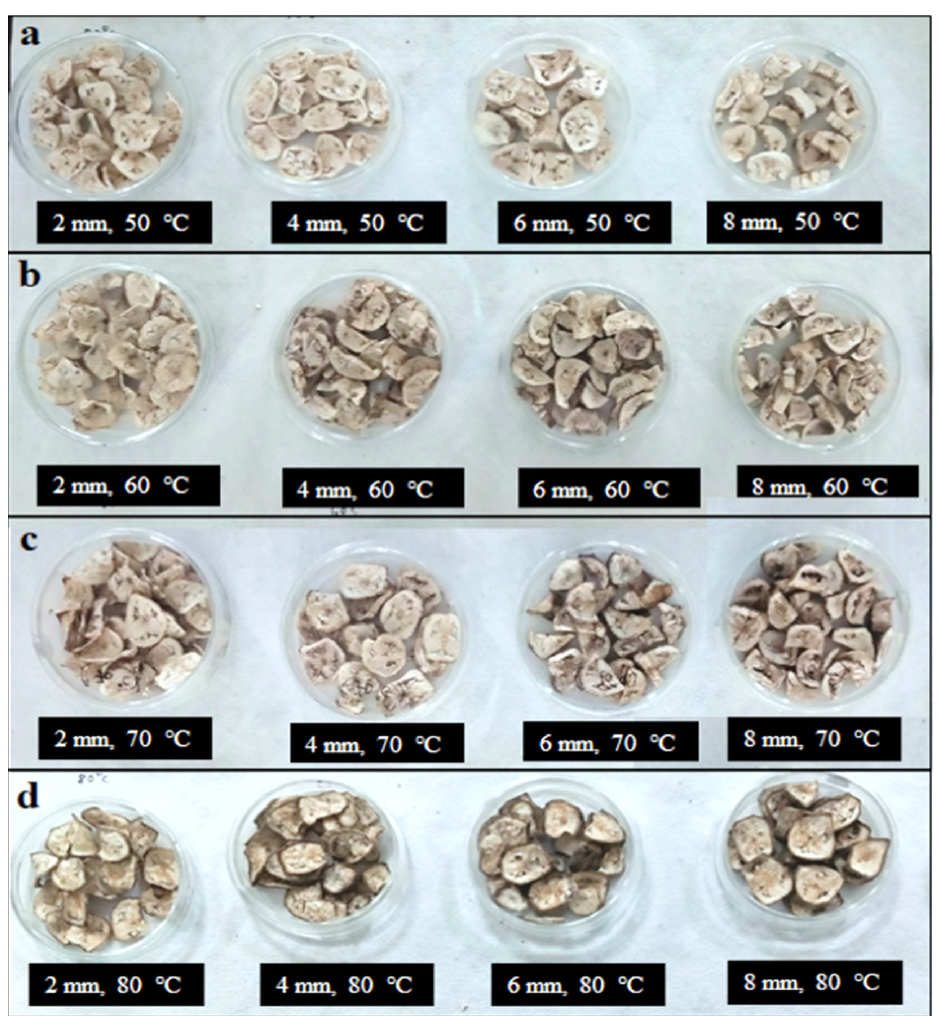
Figure 1. Convective hot-air-dried plantain banana slices with thicknesses of 2, 4, 6, and 8 mm dried at 50 °C ( a ), 60 °C ( b ), 70 °C ( c ) and 80 °C ( d ).